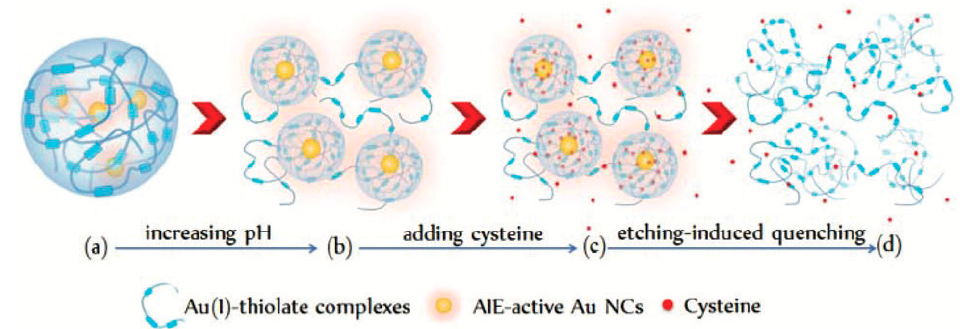
Figure 2. Schematic of the increase in the solution pH, prompting the permeation of the cysteine molecules through the Au(I)–thiolate complex surroundings to etch and quench the embedded Au NCs. ( a → b ) Increasing the pH prompts the disassembly of the Au(I)–thiolate complex network encapsulating the AIE-active Au NCs and enhances the emission; ( b → c ) alkaline pH facilitates the penetration of cysteine through the Au(I)–thiolate surroundings, thereby allowing access to the embedded Au NCs; ( c → d ) cysteine molecules etch the Au(0) cores, causing the decomposition of the AIE-active Au NC system and quenching of the emission. Adapted with permission from Ref. [30]. Copyright (2018) Royal Society of